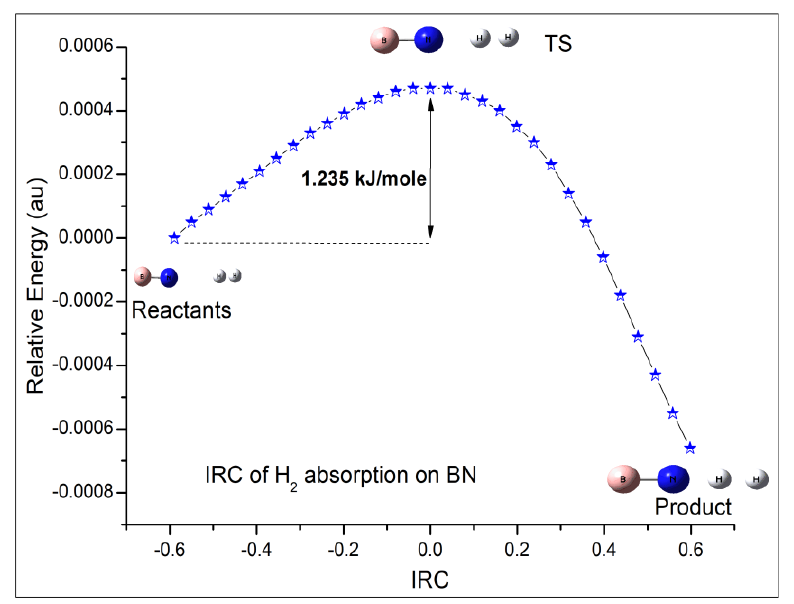
Figure 7. Relative energy profile for molecular hydrogen absorption on a single BN molecule. This figure is reproduced from Reference [20].